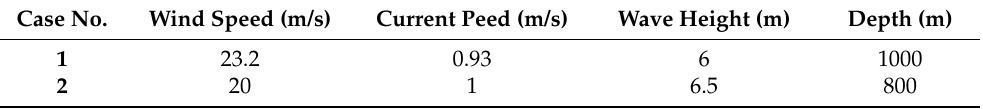
Table 3. Environmental control